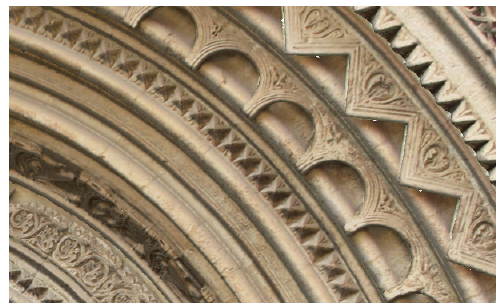
Figure 8: Result after texturing of a complex part of the object